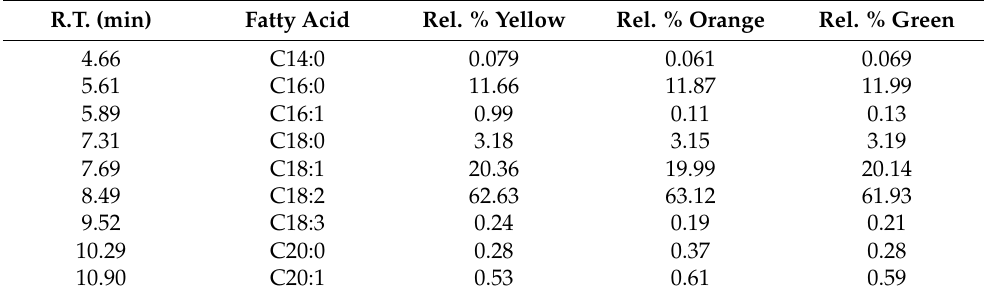
Table 2. Fatty acids composition of the seed oil from different cultivars (yellow, orange, and green) of prickly pear (g/100 g